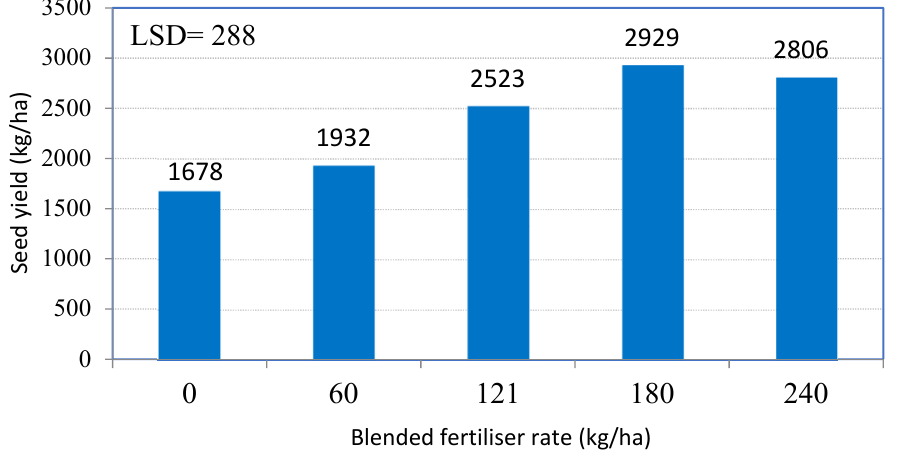
Figure 3. Effect of amounts of blended fertiliser on the faba bean seed yield.